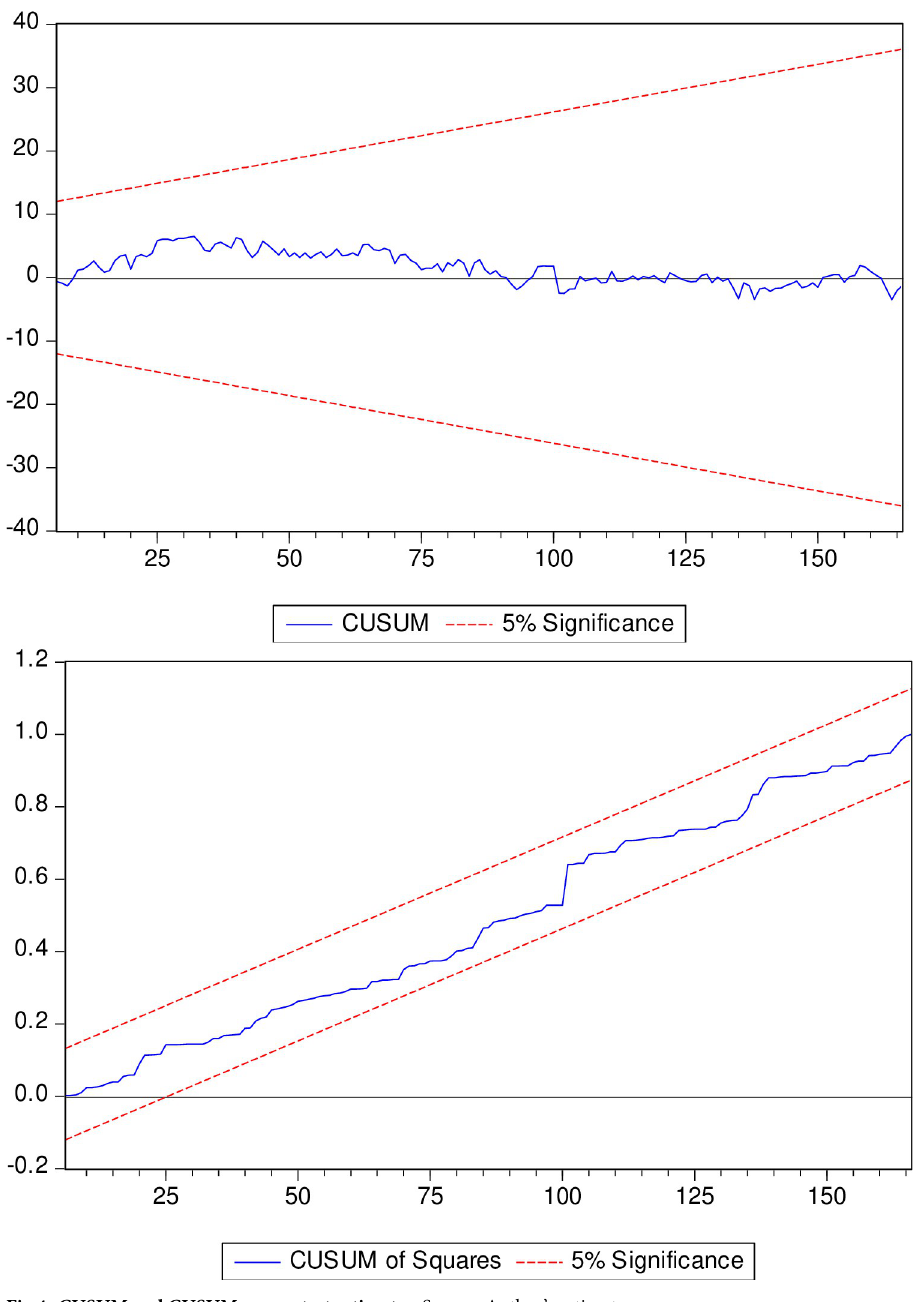
Fig 4. CUSUM and CUSUM square test estimates. Source: Author’s